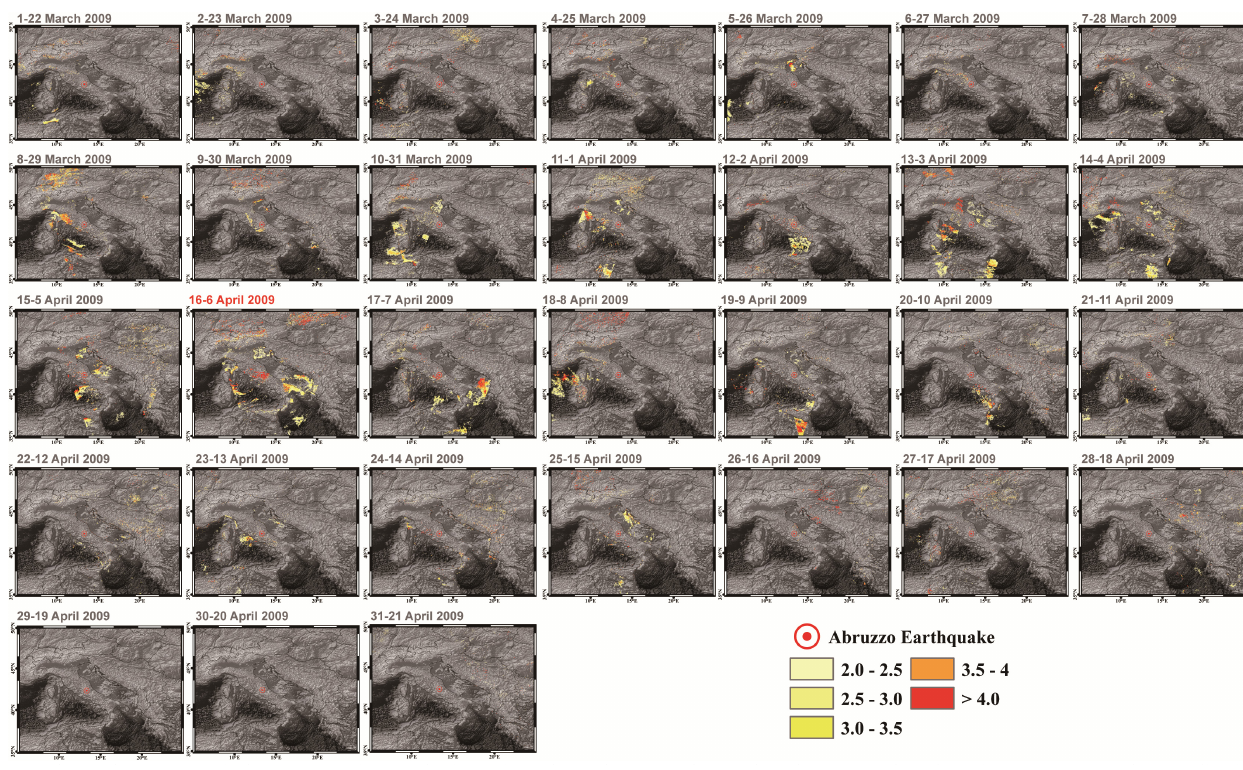
Fig. 5. Results of the RETIRA index computation on the investigated area before and after the Abruzzo earthquake using AATSR BT data (nadir view) from 22 March 2009 to 21 April 2009. Pixels with ⊗ 1T (r,t) > 4 are depicted in mars red, pixels with 3 . 5 < ⊗ 1T (r,t) < 4 are depicted in seville orange, pixels with 3 . 0 < ⊗ 1T (r,t) < 3 . 5 are depicted in solar yellow, pixels with 2 . 5 < ⊗ 1T (r,t) < 3 . 0 are depicted in autunite yellow, pixels with 2 . 0 < ⊗ 1T (r,t) < 2 . 5 are depicted in yucca yellow. Epicentre is marked with a red bullseye.